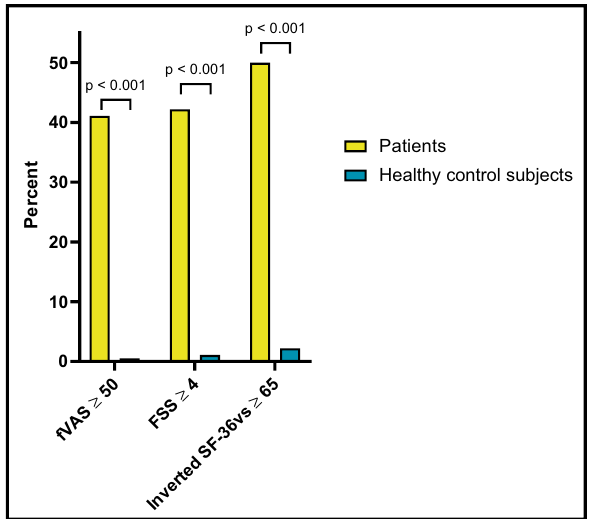
Figure 3. Prevalence of clinically relevant fatigue in 90 patients with newly diagnosed celiac disease vs. 90 healthy control subjects using defined cut-off values for fVAS, FSS and SF-36vs. Clinically relevant fatigue defined as: fVAS ≥ 50, FSS ≥ 4, and inverted SF-36vs ≥ 65. fVAS Fatigue visual analog scale, FSS Fatigue severity scale, SF-36vs Vitality subscale of the MOS 36-item short-form health survey.